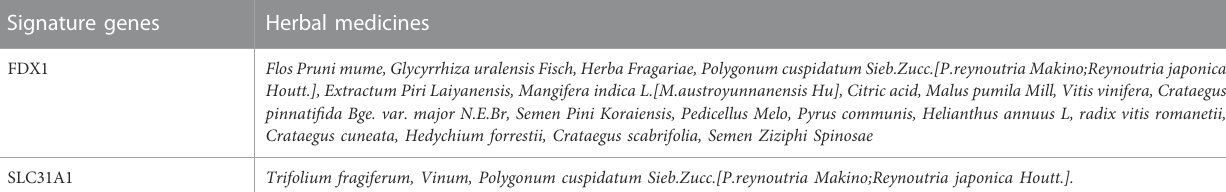
TABLE 1 The predicted herbal medicines of signature